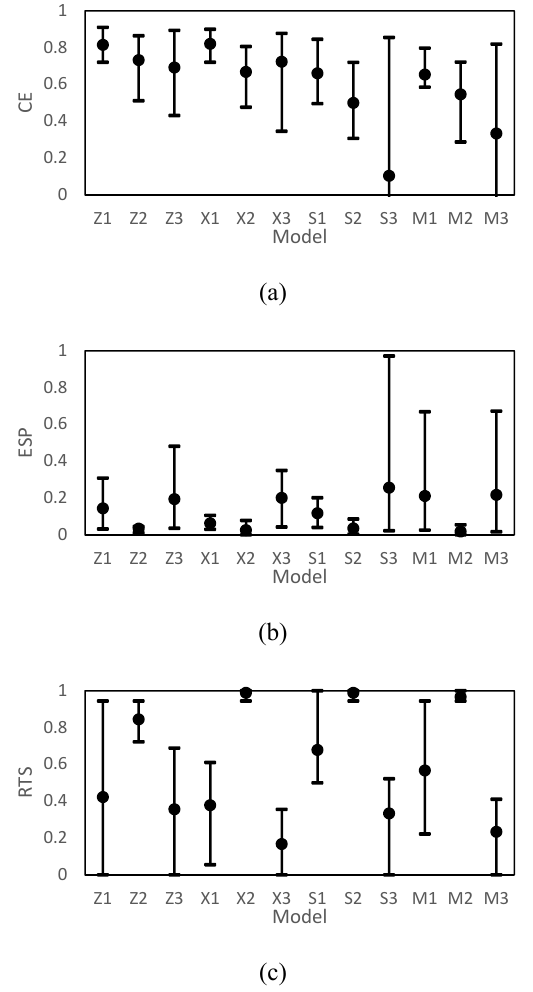
Figure 7. Comparison of model performance: (a) CE; (b) ESP; (c)